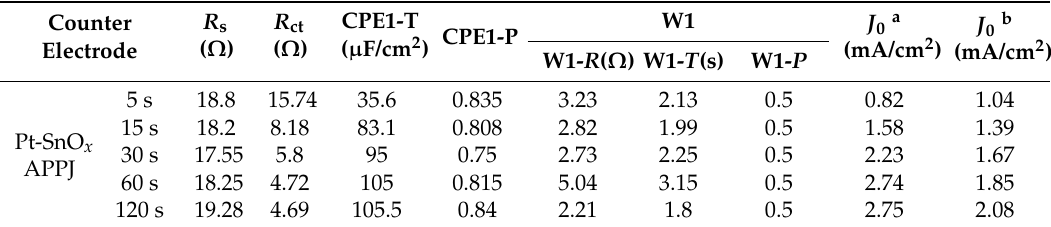
Figure 7. Photocurrent density-voltage curves of DSSCs with various CEs.